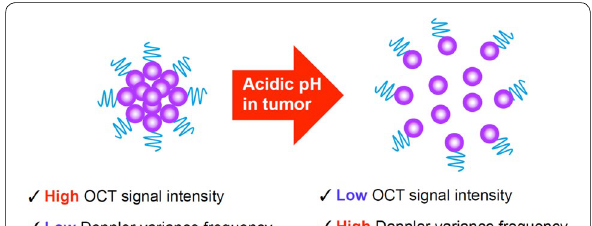
Fig. 1 Schematic illustration of OCT signal changes upon acid‑trig‑ gered transformation of Au NCs. Small Au NPs (purple) are clustered via acid‑cleavable linkers and further tethered with polyethylene gly‑ col (PEG; blue) to prevent serum‑mediated aggregation. Under acidic conditions (tumor microenvironment), the individual Au NPs will be dispersed, generating significantly reduced scattering intensity and increased Doppler variance